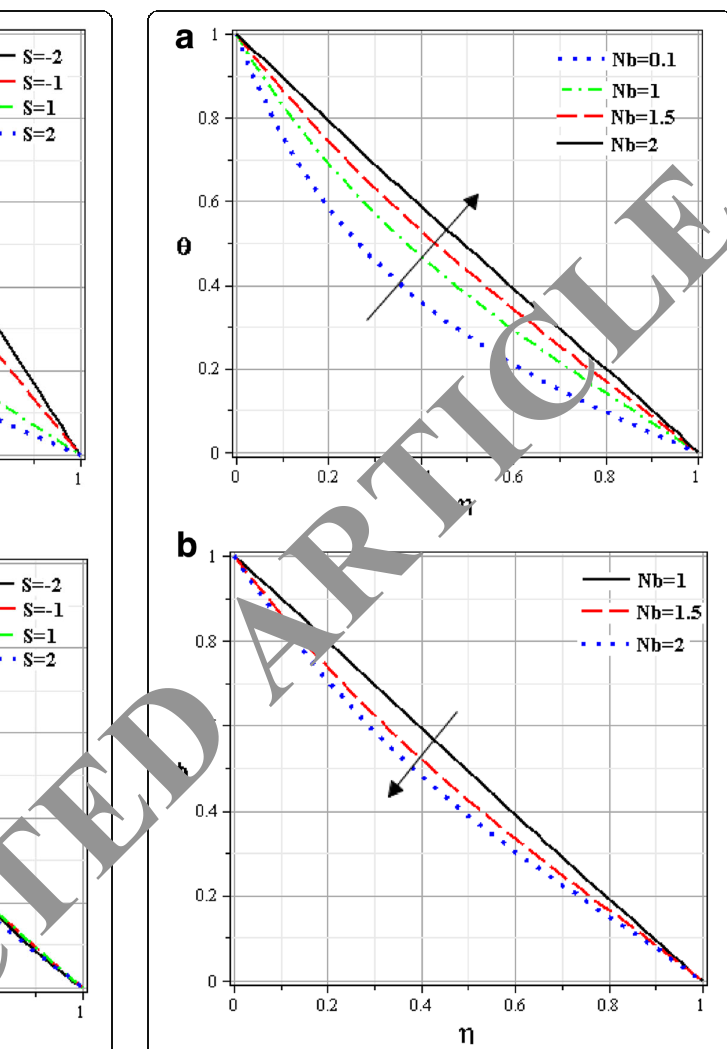
Fig. 6 a Effect of Nb parameter on temperature distribution when M = 1, A = 1, Le = 1, S = 1, Nt = 1, Pr = 6.2. b Effect of Nb parameter on concentration distribution when M = 1, A = 1, Le = 1, S = 1, Nt = 1, Pr = 6.2